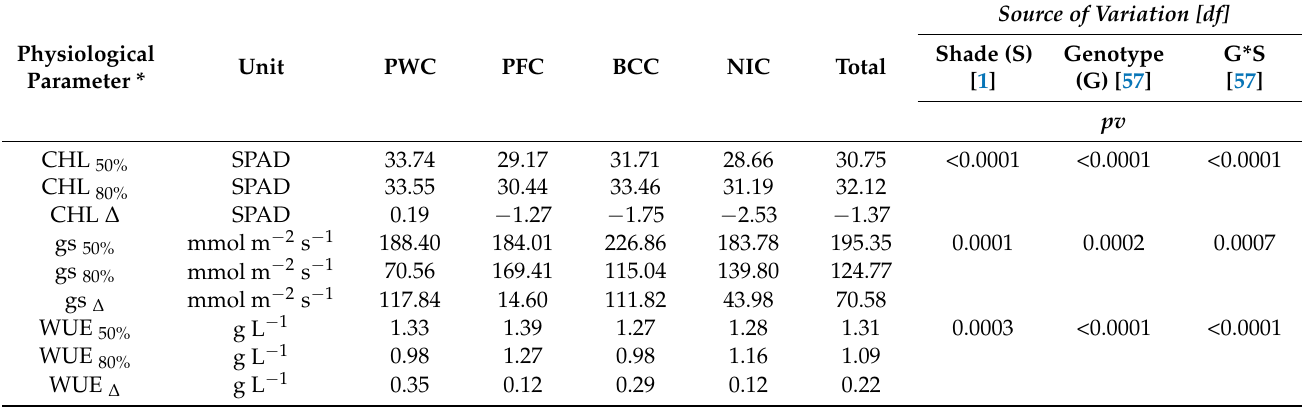
Table 3. Effect of shade on physiological parameters in 58 cacao genotypes from different origins Scheme 50 and 80% shade.